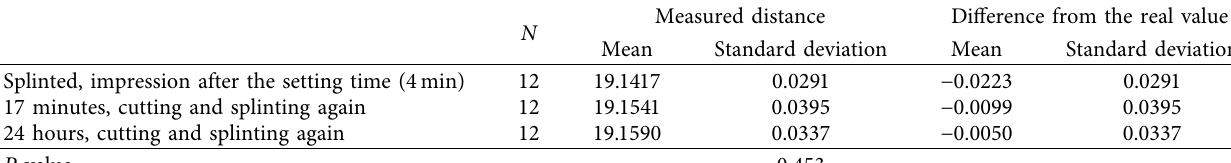
Table 2: Comparison of impression accuracy between the three groups and real value.